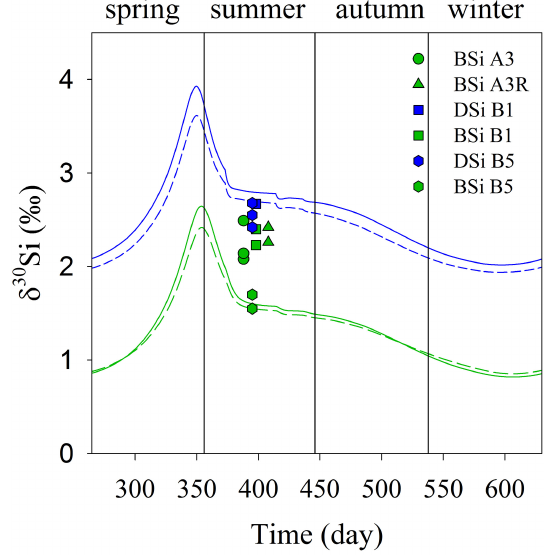
Fig. 6. Annual evolution of δ 30 Si DSi and δ 30 Si BSi in the model. Blue represents DSi and green represents BSi. Solid lines repre- sent the initial run without fractionation during BSi dissolution and dotted lines are the simulation with fractionation during BSi disso- lution. Data points are from KEOPS (Fripiat et al.,